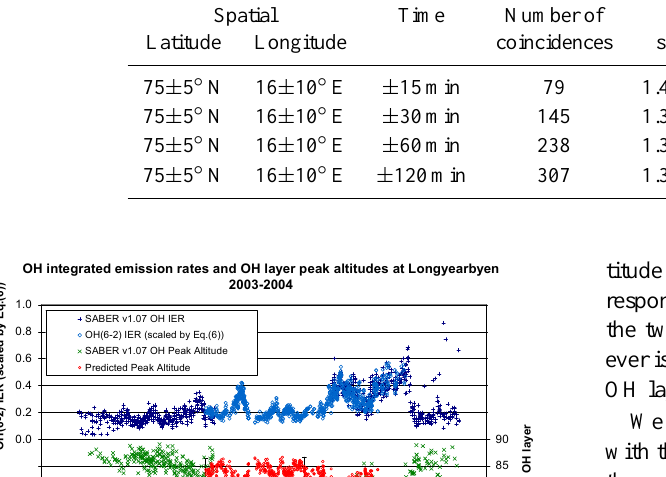
Table 2. Coincidence criteria used to relate SABER OH IER, I s , to OH(6-2) IER I g . A linear equation of the form I s = mI g + c was fitted to each coincidence set. Values of m , c and the correlation coefficient, r , are shown in the table. Spatial Time Number of linear fit Correlation Latitude Longitude coincidences slope, m constant, c coefficient, r